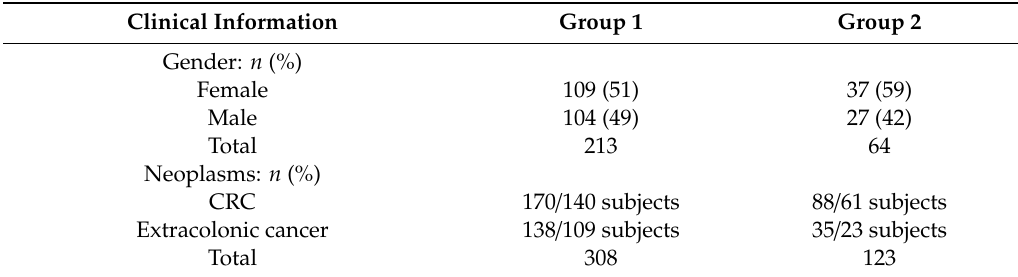
Table 2. Clinical description of individuals with cancer in Group 1 and Group 2.